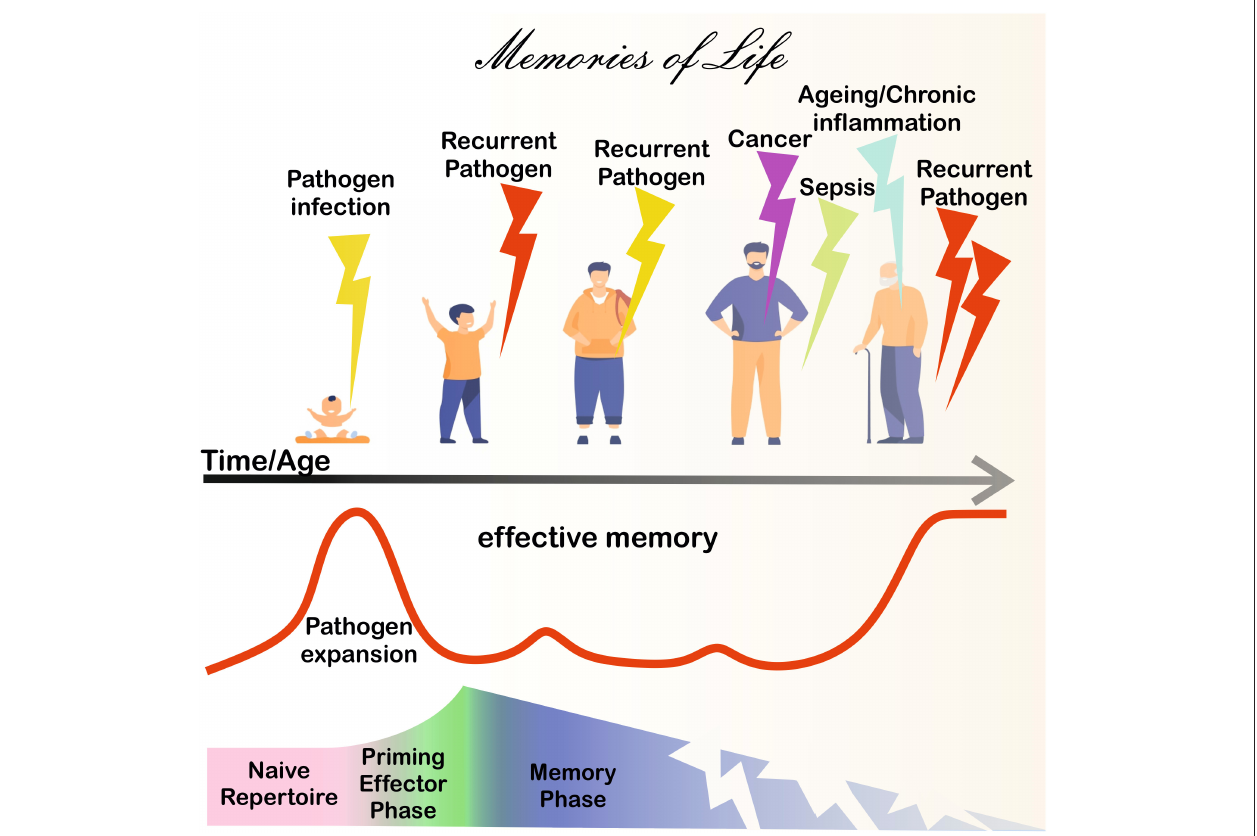
FIGURE 1 | Immunological memory during life. After birth, pathogen-derived antigens (Ags) prime adaptive immunity cells from naive precursors (pink shadowed area), eventually leading to the formation of immunological memory (blue shadowed area), after the effector phase (green shadowed area). Memory cells protect in the long-term, however the memory repertoire is continually exposed to chronic Ag sources. For instance, chronic/recurrent inflammation and/or infection due to the presence of persistent/endemic pathogens or microbial Ag (bold red line) is likely to occur throughout life. Cancer disease can further expose adaptive cells to chronic tumor Ags. Severe infections, such as sepsis and COVID-19 are associated with immunoparalysis/exhaustion and/or loss of T cells. Ultimately, chronic/persistent stimulants can lead to a deterioration of immunity, leaving individuals more vulnerable to